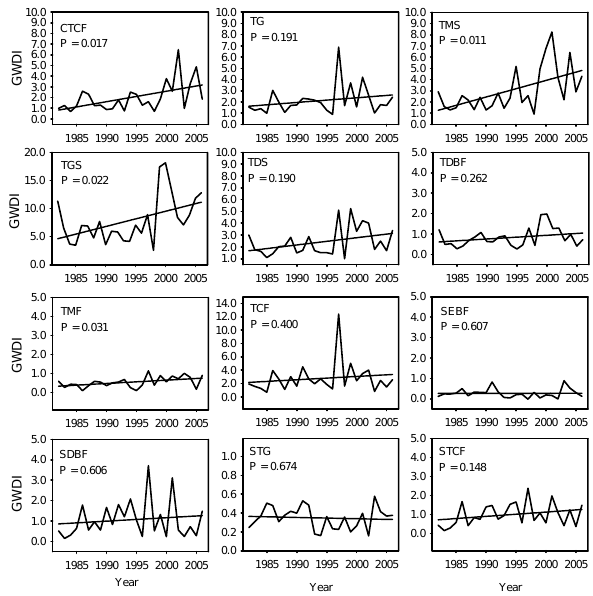
Fig. 6. Time trends of growing season water deficit index (GWDI) for twelve vegetation types during 1982–2006. Data are spatial means by vegetation type. P is the significance probability of the Mann–Kendall trend test. Fig. 7. The growing season water deficit index (GWDI) vs. (a) mean growing season precipitation (MGP) and (b) accumulated growing degree days (AGDD). All data are spatially